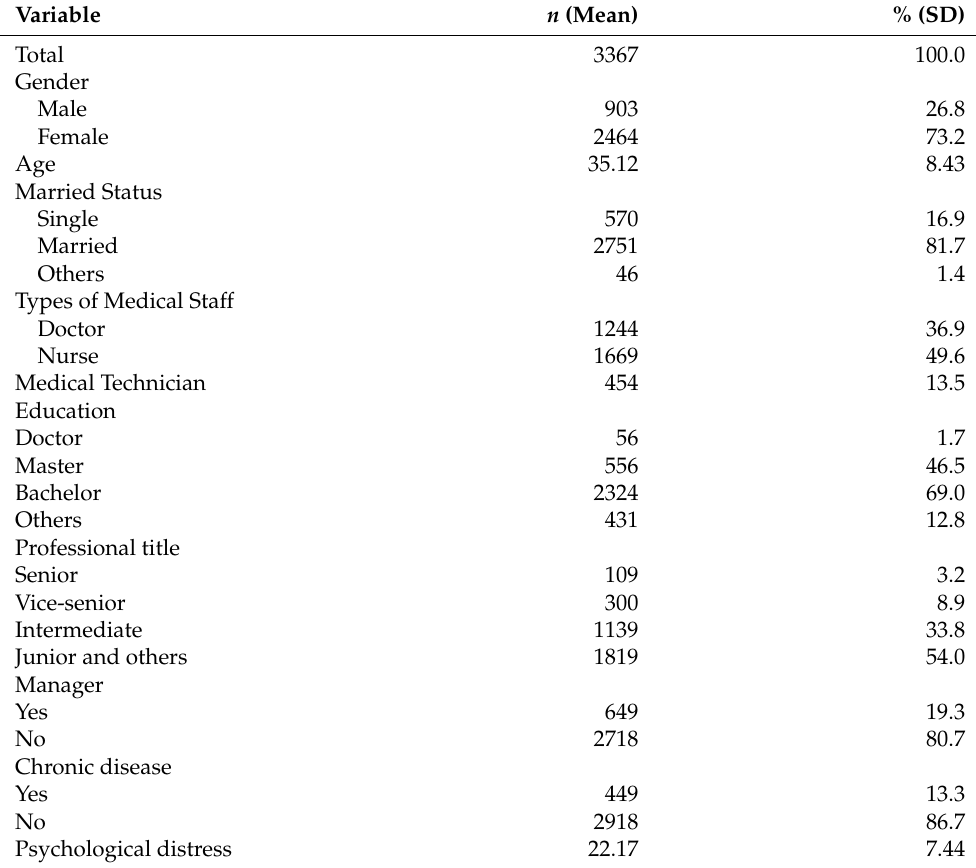
Table 1. Social-demographic characteristics, chronic disease, and psychological distress of the